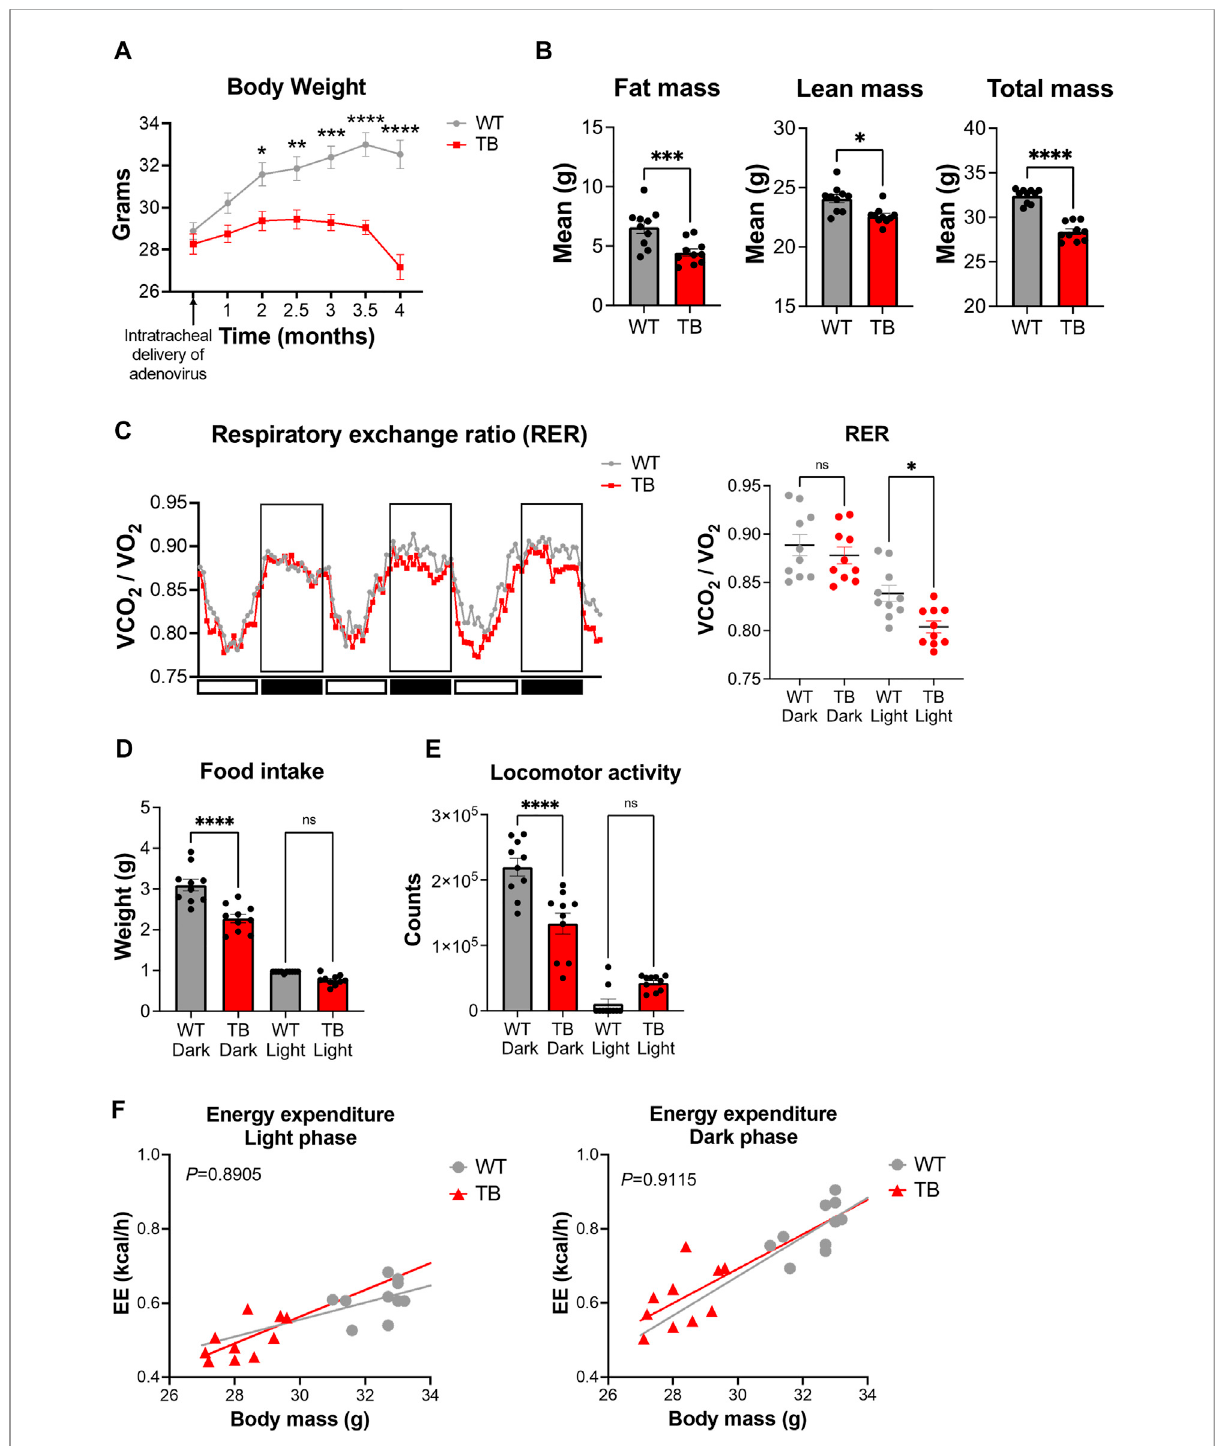
FIGURE 2 Metabolic phenotyping ofamouse modeloflung cancer-associatedcachexia. (A) Body weight overthecourseof4 months post-intratracheal delivery of the adenovirus FlpO or Cre recombinase. Data represent the mean ± SEM with p value cutoff indicated as * p < 0.05, ** p < 0.01 *** p < 0.001, and **** p < 0.0001 as determined by two-way ANOVA. (B) Fat, lean, and total mass measurements at 4 months post-delivery of adenovirus ( n = 10 mice per genotype). Data represent the mean ± SEM with p value cutoff indicated as * p < 0.05, *** p < 0.001, and **** p < 0.0001 as determined by Student ’ s t -test. (C) (Left) RER (VCO 2 /VO 2 ) in WT and TB mice over 3 days. (Right) Quanti fi cation of the mean RER in WT and TB mice over 4 days ( n = 10 mice). Data represent the mean ± SEM with p value cutoff indicated as * p < 0.05 as determined by one-way ANOVA. (D) Food